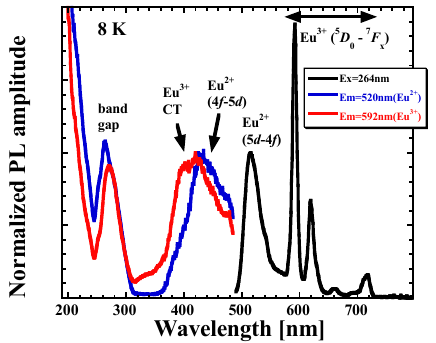
Figure 8. PL and photoluminescence excitation (PLE) spectra of KLuS 2 :Eu 2+ (0.05%) recorded at 8 K.